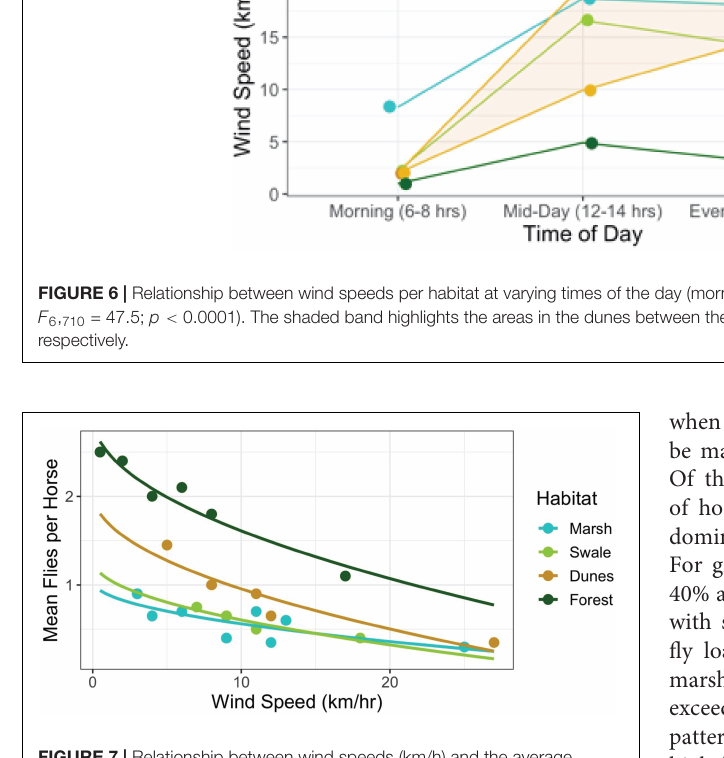
FIGURE 7 | Relationship between wind speeds (km/h) and the average number of fly landings per horse when in each habitat [Marsh: y = 1.15 – 0.63*log(x), R 2 = 0.72; Swale: y = 1.45 – 0.84*log(x), R 2 = 0.96; Dunes: y = 1.46 – 0.84*log(x), R 2 = 0.94; Forest: y = 2.47 – 0.85*log(x), R 2 = 0.79]. Note, that fly landings decline non-linearly as wind speed (km/h) increases in all habitats. Apart from the forest habitat, however, the decline approaches an asymptote of around 0.33 flies per horse at 25